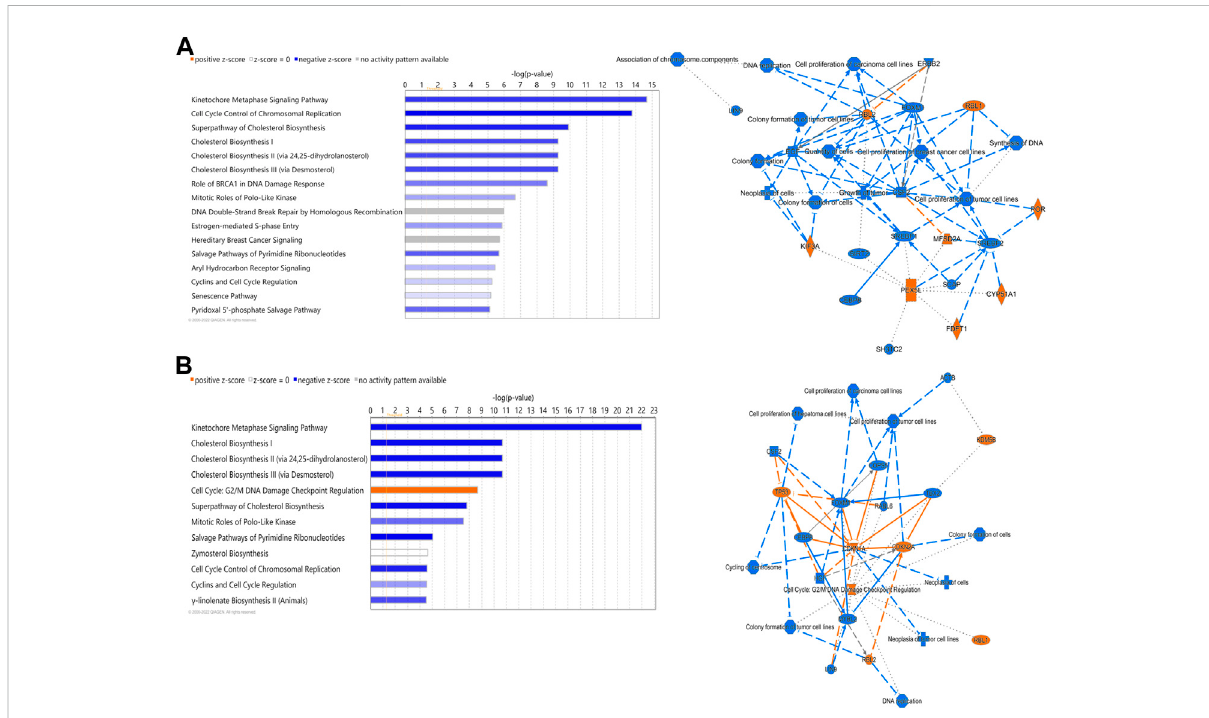
Canonical pathways of differentially expressed hepatic genes between DLY and FED chicks. (A) Genes with a fold-change ≥ 2; FDR p -value ≤ 0.05and (B) Geneswithafold-change ≥ 5;FDR p -value ≤ 0.05.Orangeindicatesapositivez-score;expressionpatternsofmemberspredicts activation of the pathway. Blue indicates a negative z-score; expression patterns of members predicts inhibition of the